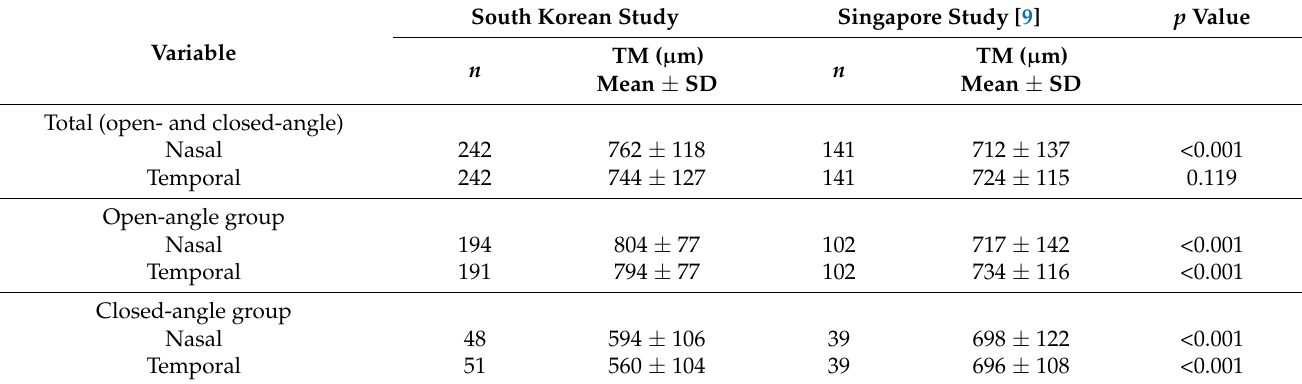
Table 5. Comparison of TM heights of South Koreans with previously reported data in the Singaporean study.